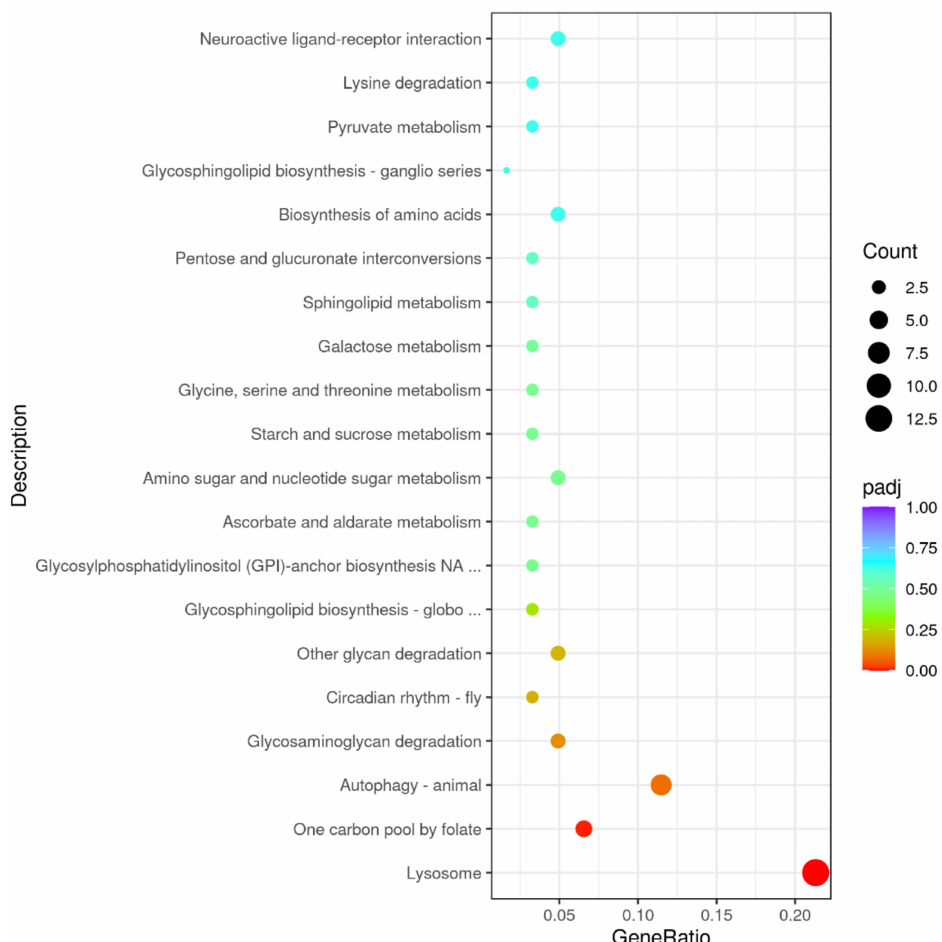
Figure 6. KEGG enrichment analysis of DEGs in viruliferous and non-viruliferous SBPH heads. X-axis represents the ratio of the number of DEGs annotated to the KEGG pathway to the total number of DEGs; Y-axis represents KEGG pathways. The size of the dots represents the number of genes annotated to the KEGG pathway and the padj value ranges from 0 to 1; lower values mean greater